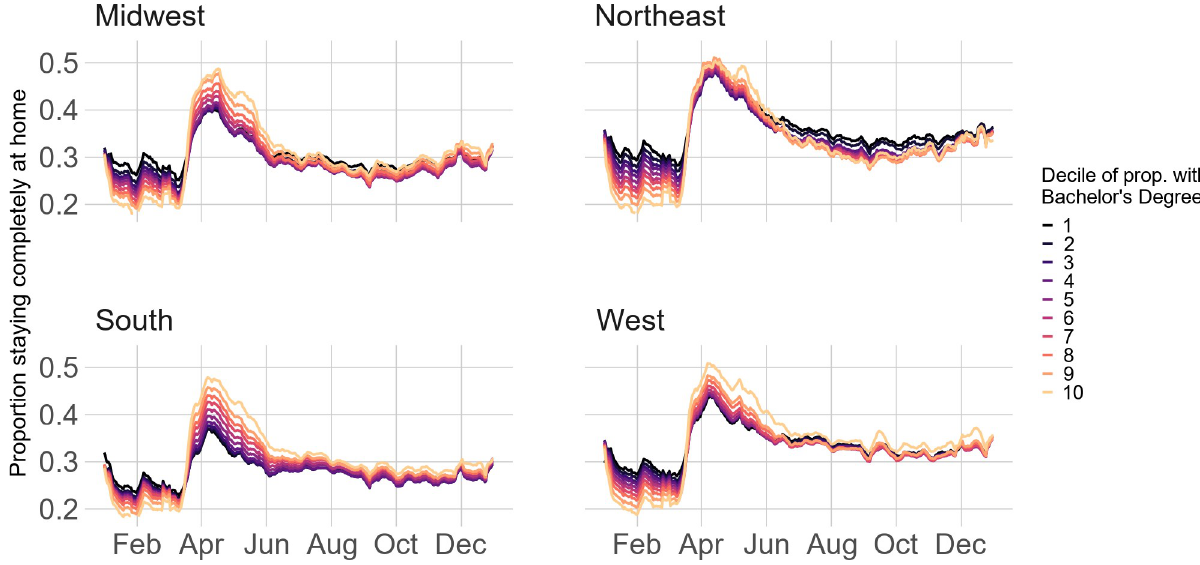
Fig 5. Stay-at-home patterns by Census region and proportion Bachelor’s degree holders.